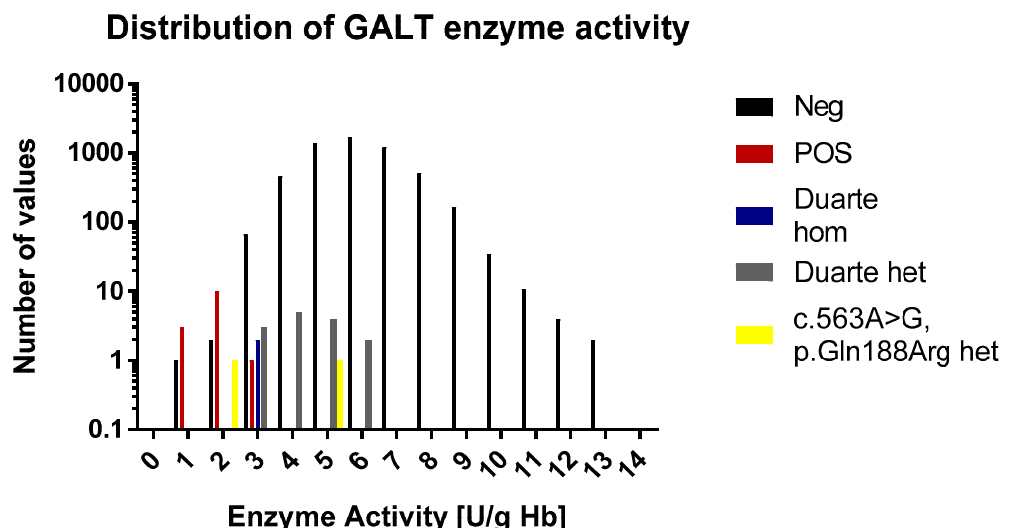
Figure 3. A histogram over the distribution of GALT enzyme activity results of the study. The histogram is divided into 0.2 mmol / L bins. Each sample category is signified by a separate color. For the sake of easy comparison the y axis is logarithmic in scale.